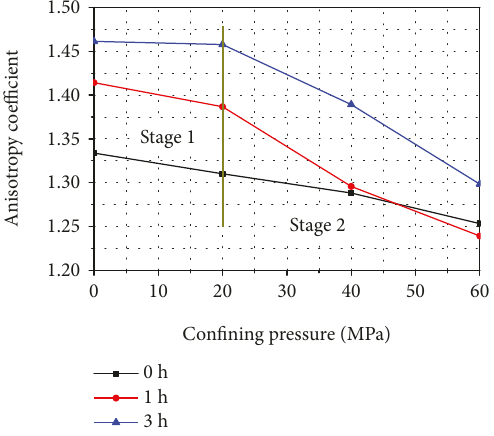
Figure 8: Shale anisotropy coe ffi cient with con fi ning pressure and WBM